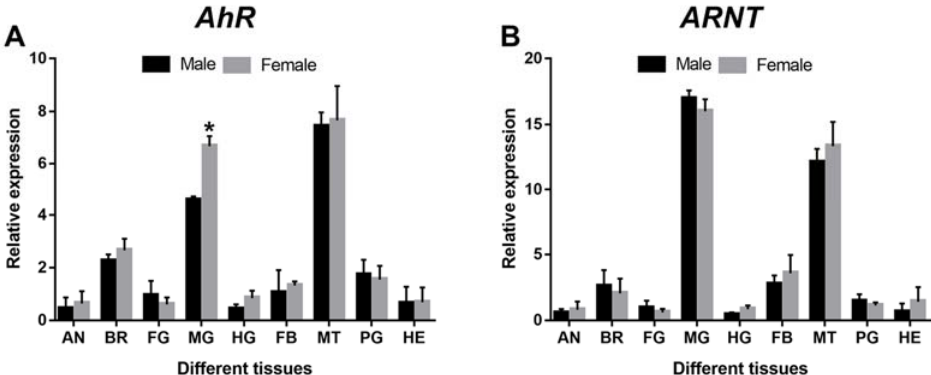
Figure 3. Relative expression levels of emerged adults of AhR ( A ) and ARNT ( B ) in different tissues of D. armandi . The relative expression levels were normalized with β -actin and CYP4G55 . The asterisk indicates a significant difference between female and male expression levels (* p < 0.05, independent Student’s Test). All values are mean ± SE , n = 3. AN, antennae; BR, brain; FG, foregut; MG, midgut; HG, hindgut; FB, fat body; MT, Malpighian tubules; PG, pheromone gland; HE, hemo ‐ lymph.